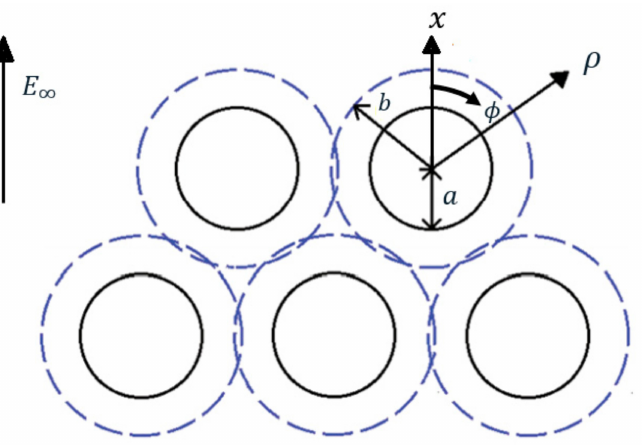
Figure 1. Geometrical sketch of the unit cell model for an array of long parallel circular